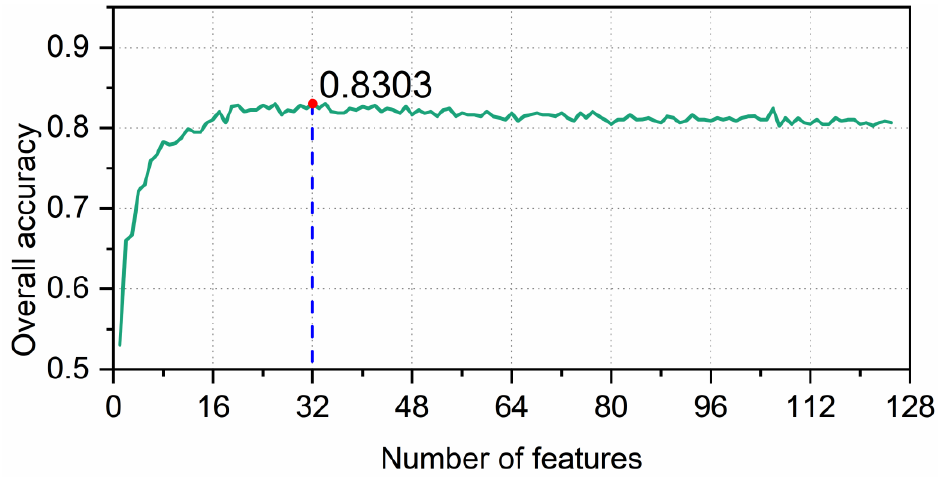
are from the GF-1 NIR band. Mean and entropy extracted from the GF-1 NIR band in 7 × 7 window rank top among texture features.